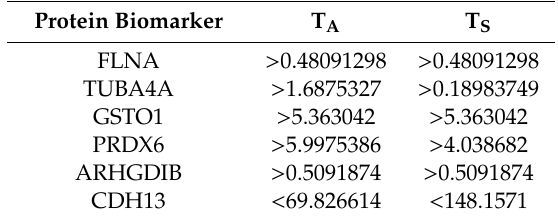
Table 3. Threshold values and positivity of the biomarkers when optimizing the global accuracy (T A ) or the sensitivity or specificity (T S ) of the panel, as defined by PanelomiX